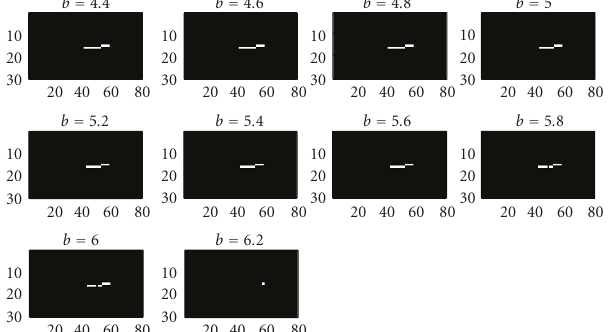
Figure 18: NA23A sequence, s n = 4, target’s track versus b .